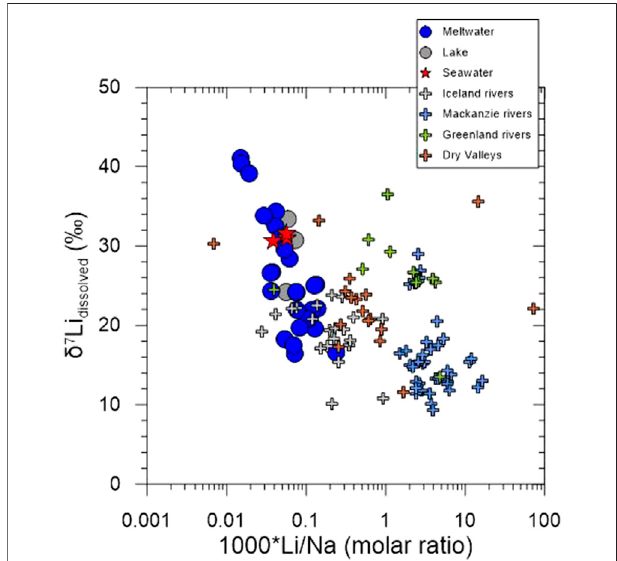
FIGURE 7 | Plot of δ 7 Li versus Li/Na (molar ratio) in the water samples. Data for Iceland, Mackenzie and Greenland rivers, and the McMurdo Dry Valleyare fromVigier et al.(2009), Millot etal. (2010),Wimpennyet al.(2010a), and Witherow et al. (2010),